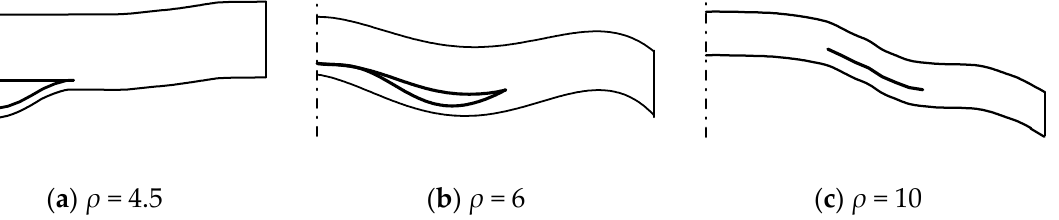
Figure 16. Buckling modes of axi-symmetric spherical shell with a single delamination being the function of the shallowness parameter ρ .